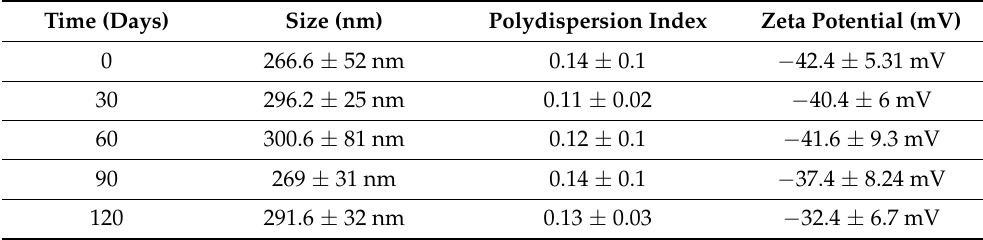
Table 3. Colloidal stability of NP-ZN-MSZ after 120 days at room temperature. Time (Days) Size